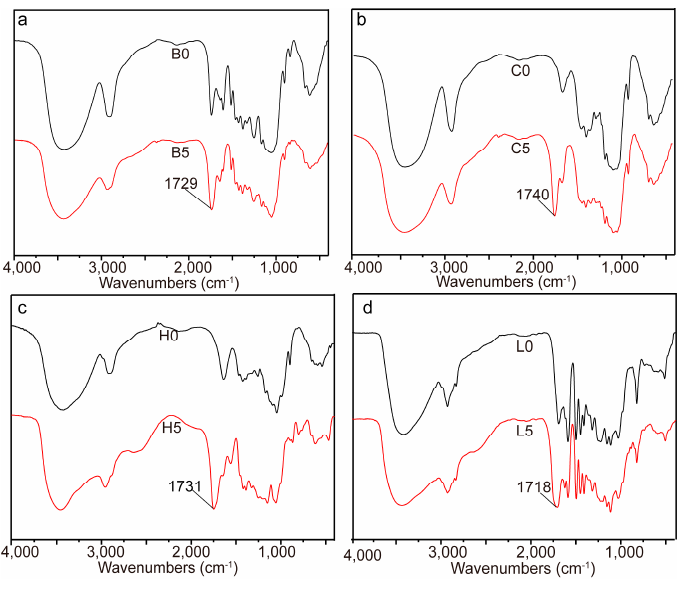
Figure 1. FT-IR spectra of bagasse ( a ); cellulose ( b ); hemicelluloses ( c ); and lignin ( d ) samples.